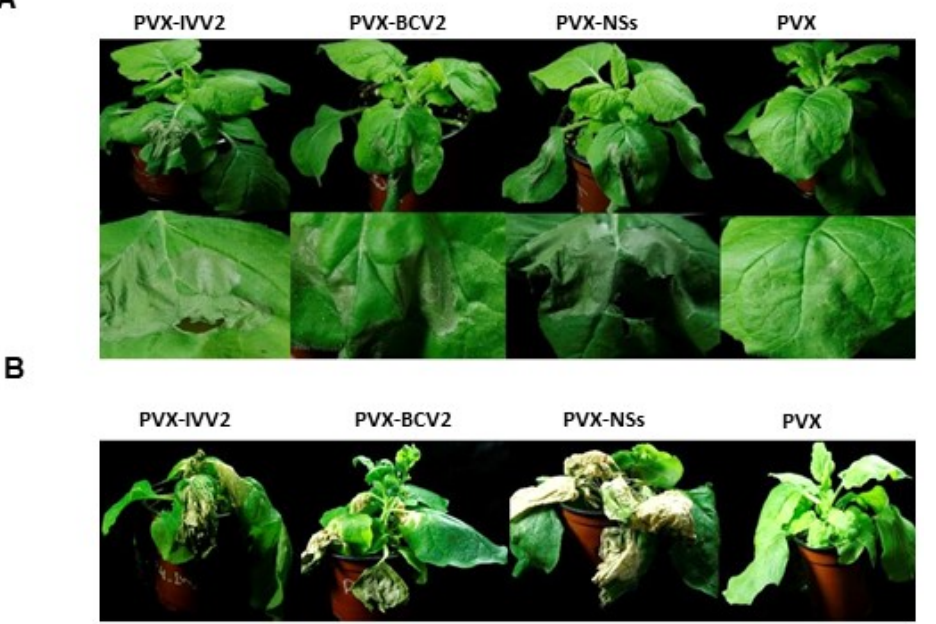
Figure 4. Local and systemic symptoms induced by Potato virus X (PVX) expression of V2 from beet curly top Iran virus (PVX-IVV2) in wt Nicotiana benthamiana plants. Empty PVX vector (PVX) was used as negative control. Recombinant PVX viruses expressing either the nonstructural protein (NSs) from tomato spotted wilt virus (PVX-NSs) or the V2 protein from beet curly top virus (PVX- BCV2) were used as positive controls. ( A ) Local symptoms induced in the infiltrated area at 6 dpi. ( B ) Representative plants showing systemic symptoms at 16 dpi. Four to six plants were agroinfil- trated per experiment. Similar results were obtained in three independent experiments.